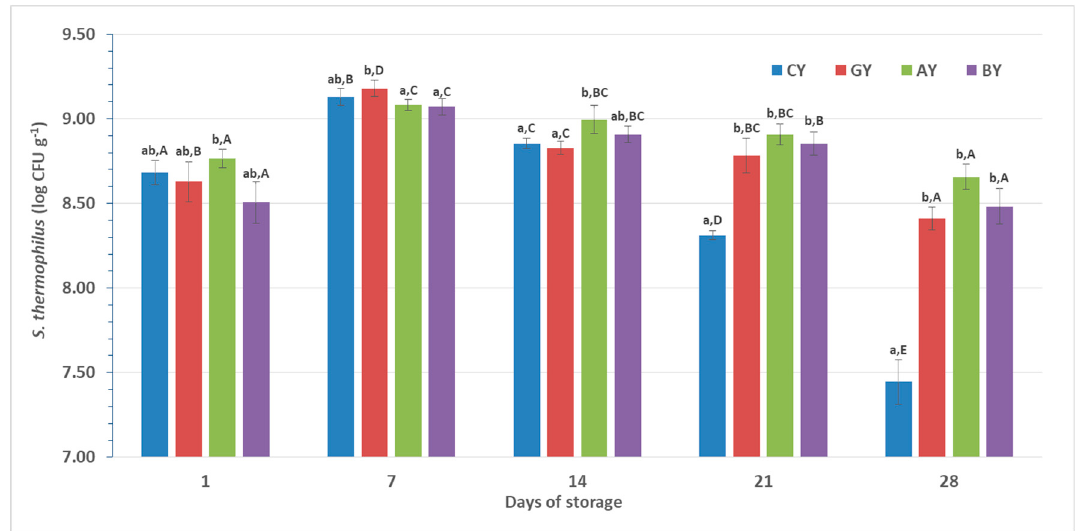
Figure 3. Viability of S. thermophilus in yogurts during refrigerated storage; CY = control yogurt; GY = yogurt with grape juice; BY = yogurt with blueberry juice; AY = yogurt with aronia juice; a–b Different lowercase letters in the columns, at the same day of storage, indicate significant differences ( p < 0.05); A–E Different uppercase letters in the columns, at the same yogurt, indicate significant differences ( p < 0.05).